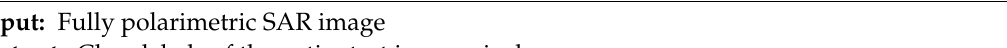
Algorithm 1 The feature vector-based NRS-MRF